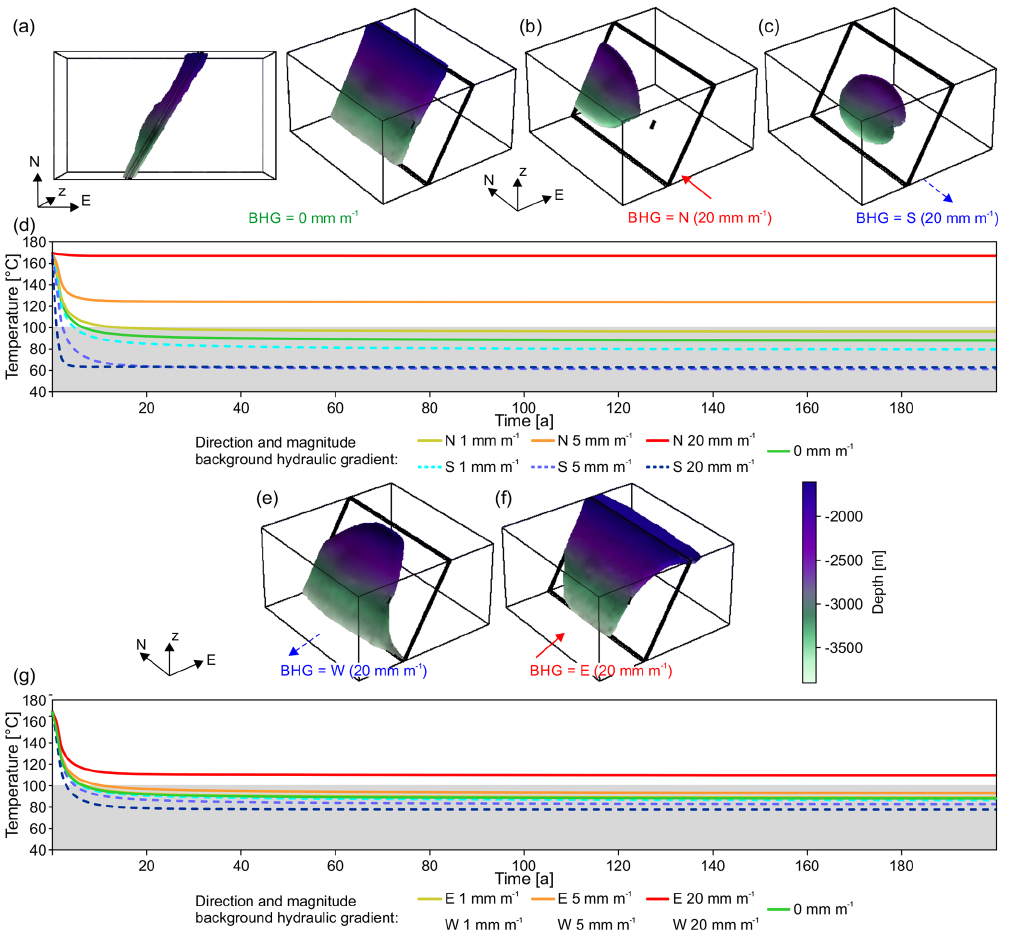
Figure 7. Temperature development and shapes of the HDI for faults that consist of a damage zone with a positive fault-parallel fracture anisotropy. In panels (a) , (b) , and (c) , the shapes of the HDI after 100 years for fault-parallel BHGs are shown. The HDI is restricted to the damage zone. Fault-parallel BHG has a strong effect on the shape of the HDI. Panels (d) and (g) show the temperature developments over time of the produced fluid and contain the results of 13 individual simulations. Panel (d) shows how the highest northward BHGs hinder thermal depletion efficiently, while southward BHGs cause almost immediate depletion. In panels (e) and (f) , the shapes of the HDI for BHGs normal to the strike of the fault after 100 years are shown. Together with panel (g) they show that a BHG in dip direction of the fault has a negative effect on reservoir lifetime, compared with a BHG opposed to the dip direction, which leads to a very short thermal lifetime, i.e. less than 10